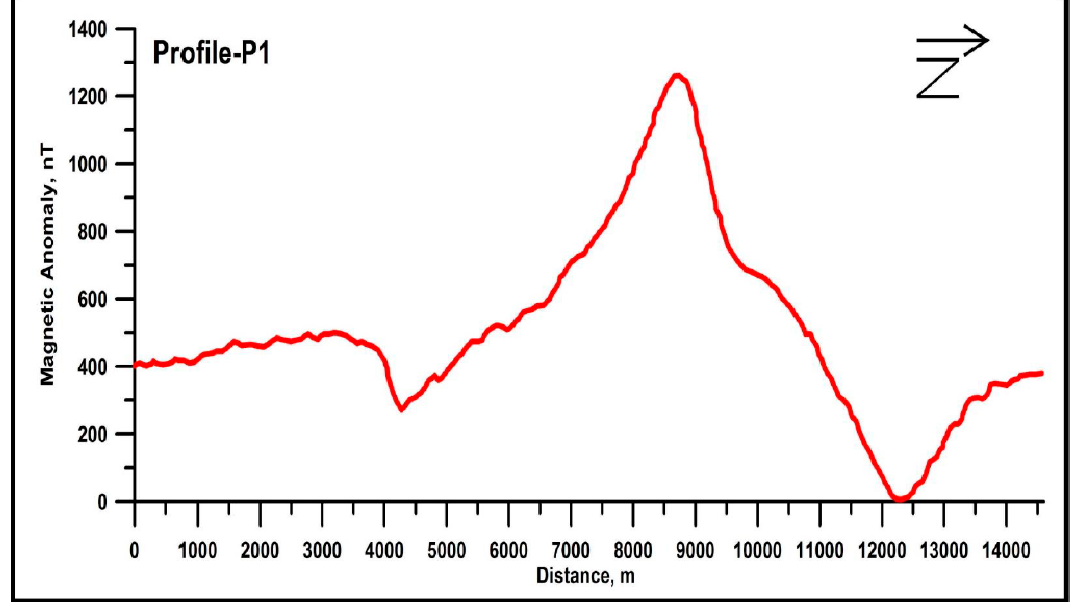
Figure 6. Observed total intensity magnetic anomaly along profile P1.